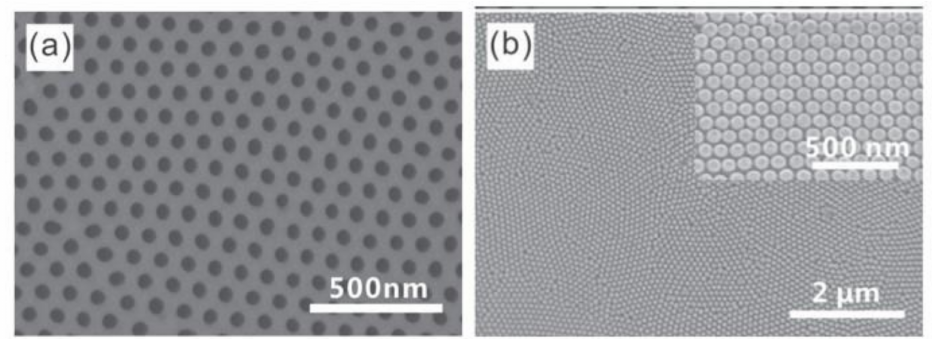
Figure 9. P(VDF-TrFE) nanodot arrays at different scales: ( a ) 500 nm, ( b ) 2 µ m; taken with SEM (Reproduced with permission from [54]. Copyright Wiley and sons,